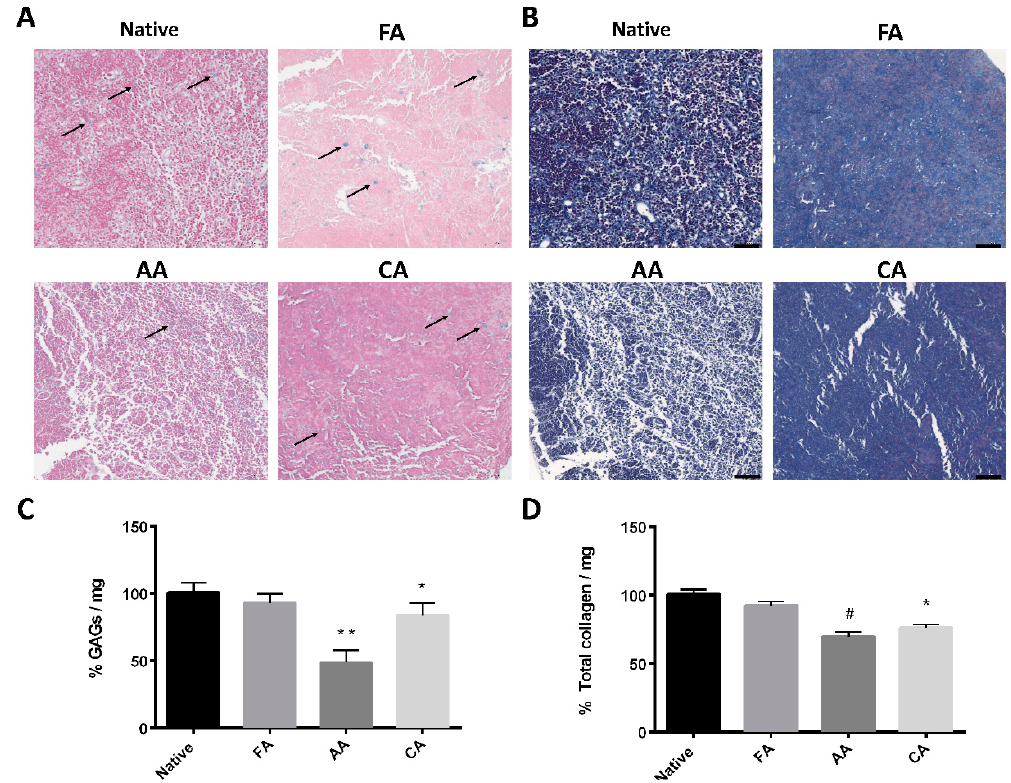
Figure 2. Examination of glycosaminoglycan (GAG) content (blue, black arrows) and collagen content in decellularized lymph node (dLN) scaffolds. ( A ) Alcian Blue staining of a native lymph node and lymph nodes treated with formic acid (FA) 30%, acetic acid (AA) 30%, and citric acid (CA) 30%. (Scale bar: 50 µm). ( B ) Masson’s trichrome staining of a native lymph node and lymph nodes treated with formic acid (FA) 30%, acetic acid (AA) 30%, and citric acid (CA) 30%. (Scale bar: 50 µm). Contents of ( C ) GAGs and ( D ) total collagen of lymph nodes treated with various organic acids are compared to a native lymph node. (Data are presented as the mean ± SD, *: p < 0.01, **: p < 0.05, #: p < 0.001.).